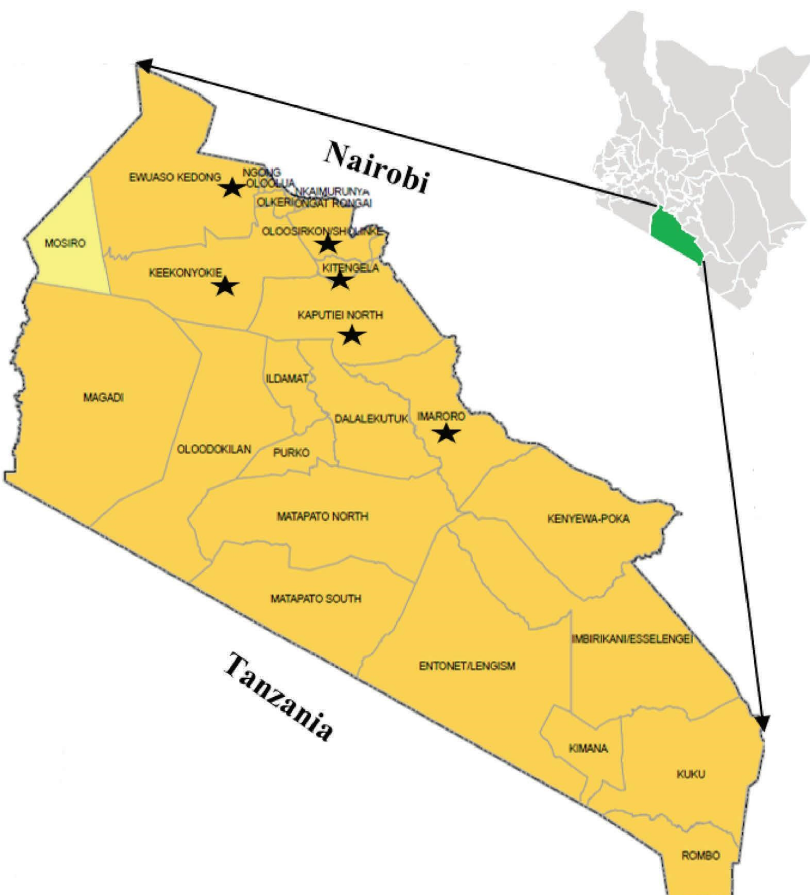
Figure 1: A map of Kajiado County showing its location in Kenya and sites where sampling and interviews on antimicrobial use among livestock farmers were